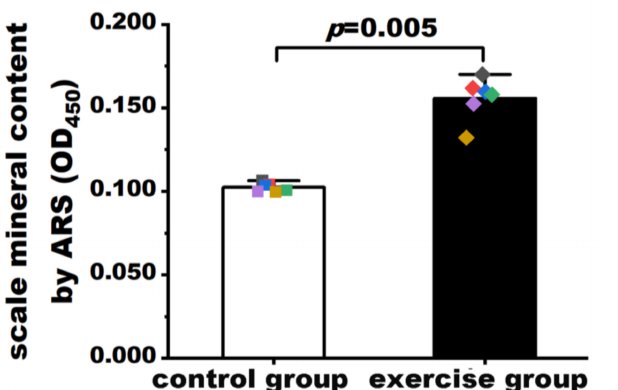
Figure 2. Quantification of mineralization in scales of the exercise and control groups. Values are expressed as mean and standard deviation. Student’s t test was used to compare the differences in mineralization levels between the exercise group and the control group. The black, red, blue, green, purple, and yellow squares represent control group fish numbers 13, 14, 15, 16, 17, and 18, respectively. The black, red, blue, green, purple, and yellow diamonds represent exercise group fish numbers 14, 15, 16, 17, 18, and 19, respectively.